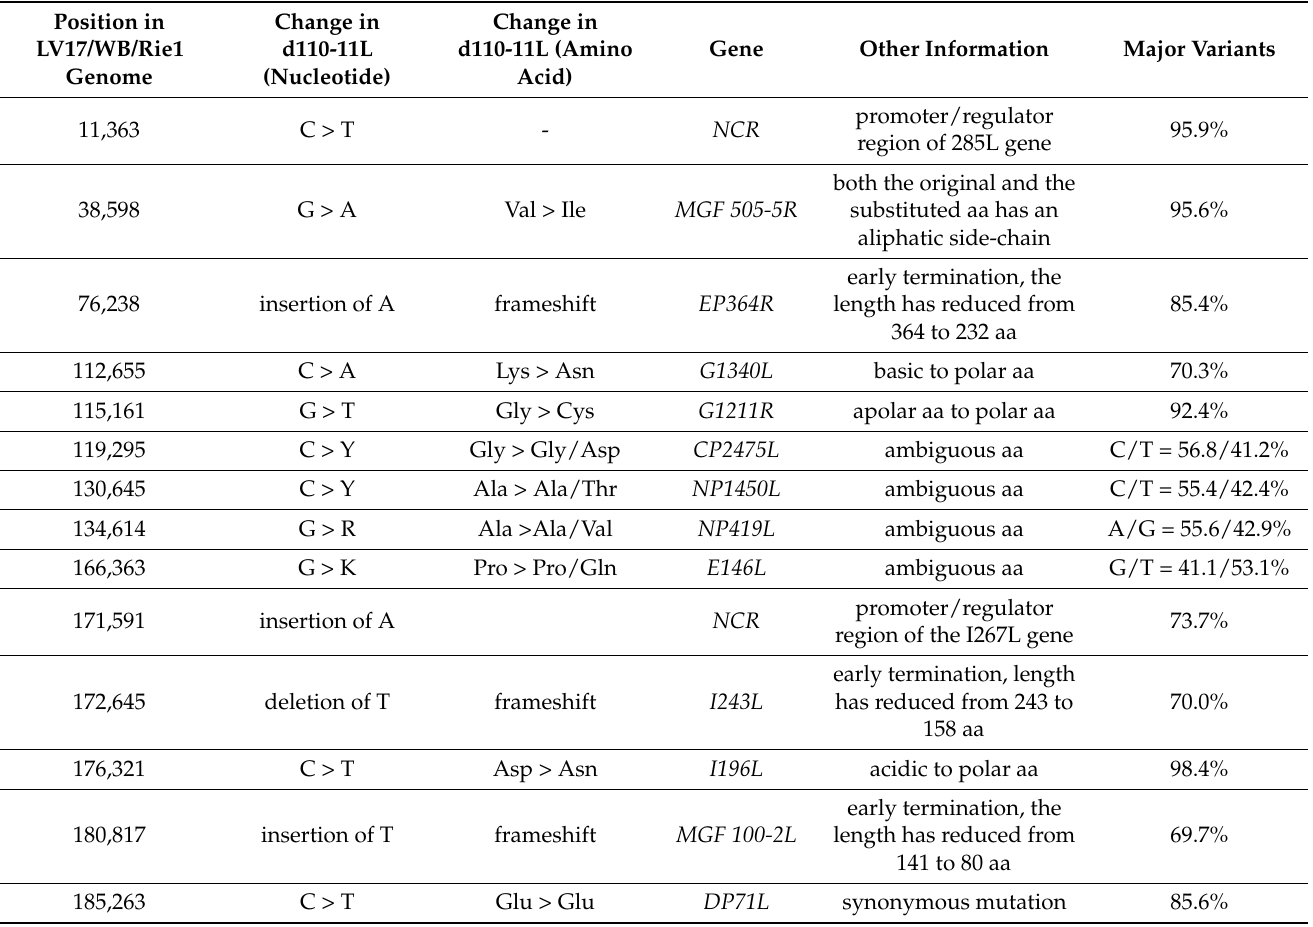
Table 5. Comparison of the genomes of LV17/WB/Rie1/d110-11L and LV17/WB/Rie1